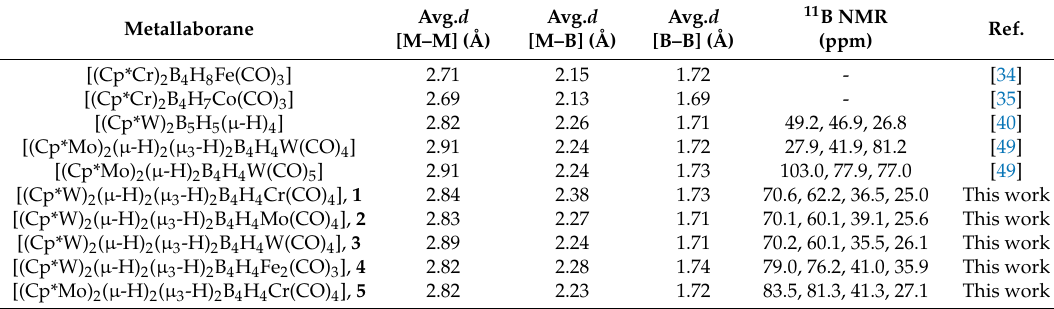
Table 1. Selected structural parameters and chemical shifts ( 1 H and 11 B NMR) of metallaboranes 1 – 5 and other related clusters.